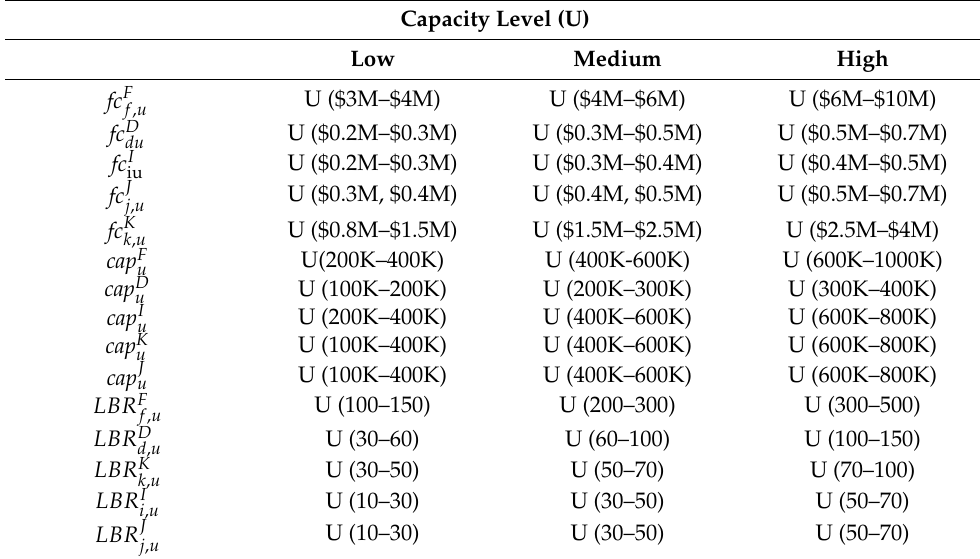
Table 5. Parameters at multi-capacity levels.